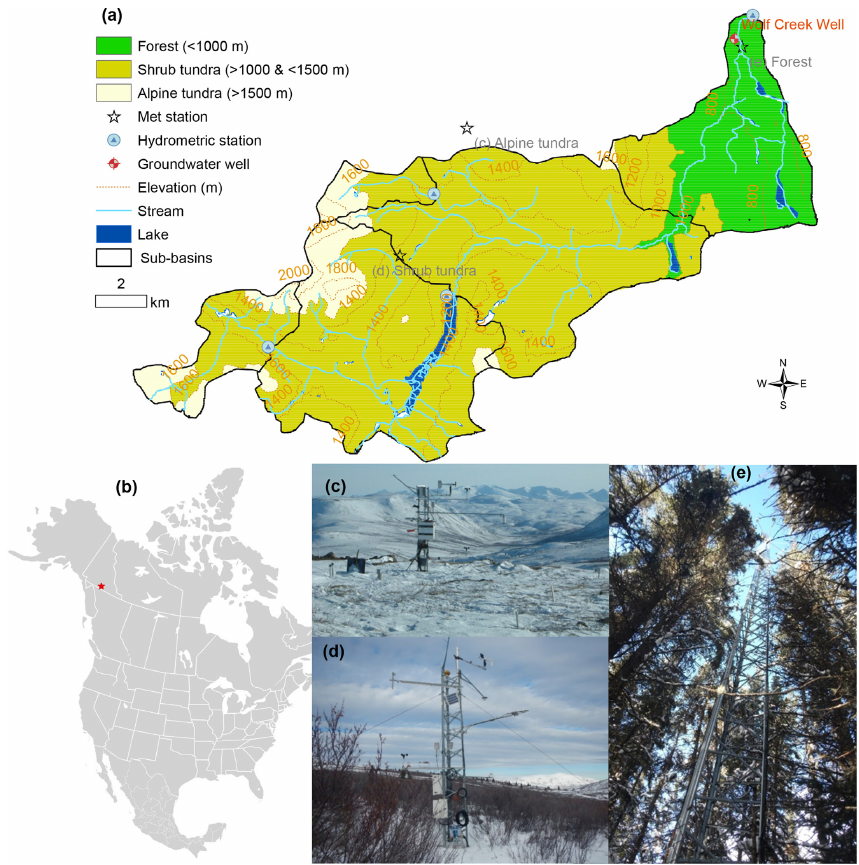
Figure 1. (a) The topography, streams, lakes, land-cover, groundwater well, hydrometric stations, five sub-basins, and three meteorological stations within the Wolf Creek Research Basin, Yukon Territory, Canada, shown in the (b) map of North America. Three meteorological stations represent (c) alpine tundra, (d) shrub tundra–taiga, and (e) forest